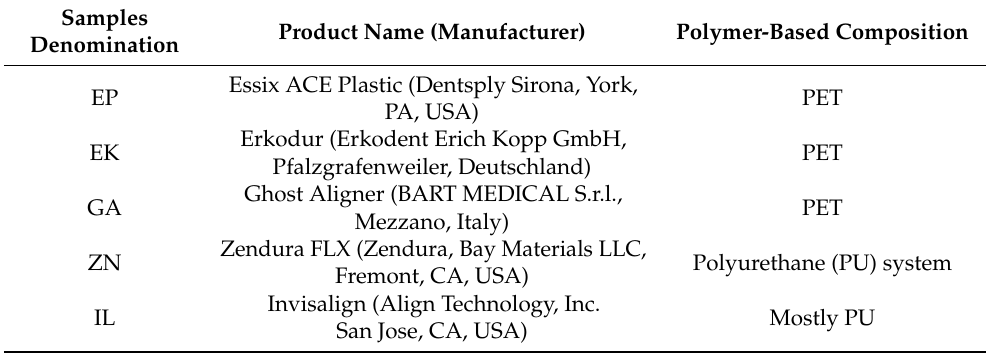
Table 1. The considered clear aligners in terms of manufacturer and polymer-based composition, as evidenced in the material safety data